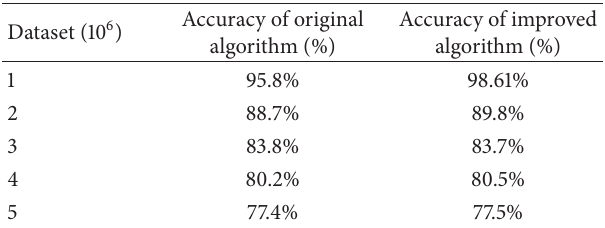
Table 3: Classification accuracy of original algorithm and improved